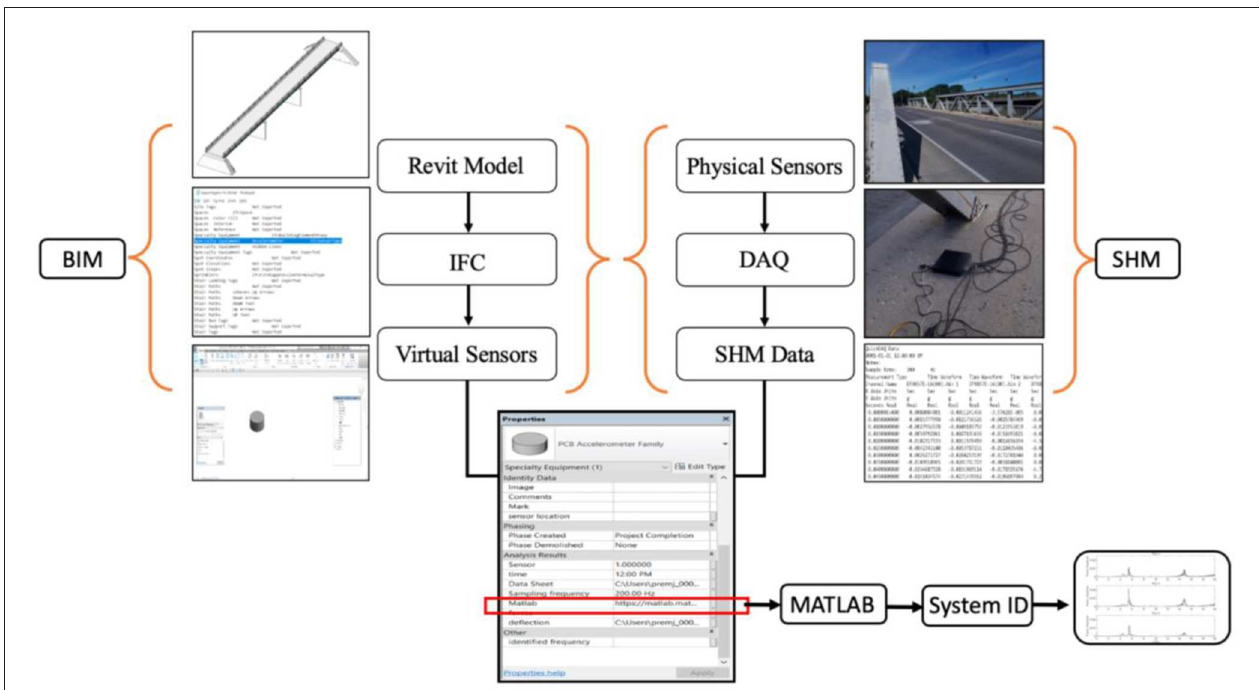
FIGURE 4 | Proposed framework of the BIM-based SHM tool.